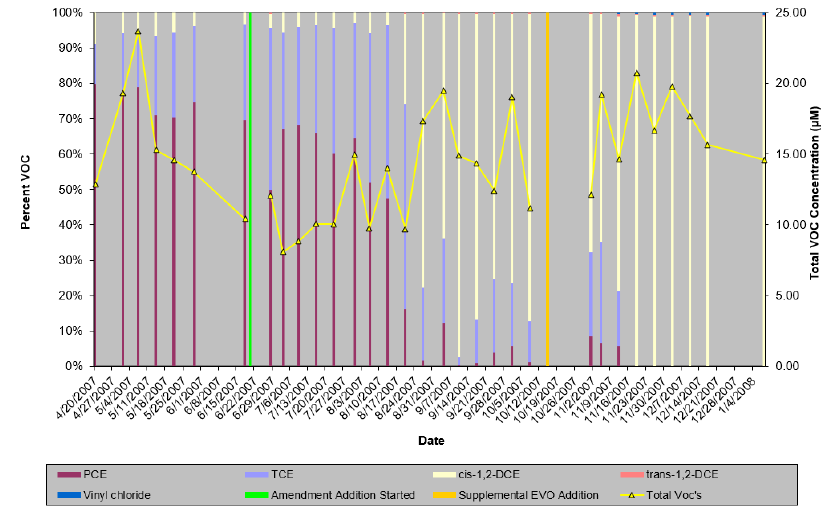
Figure 7. Comprehensive test cell data summary: Whey/EVO, HSE-6/HSI-8, HSE-6% VOC, and